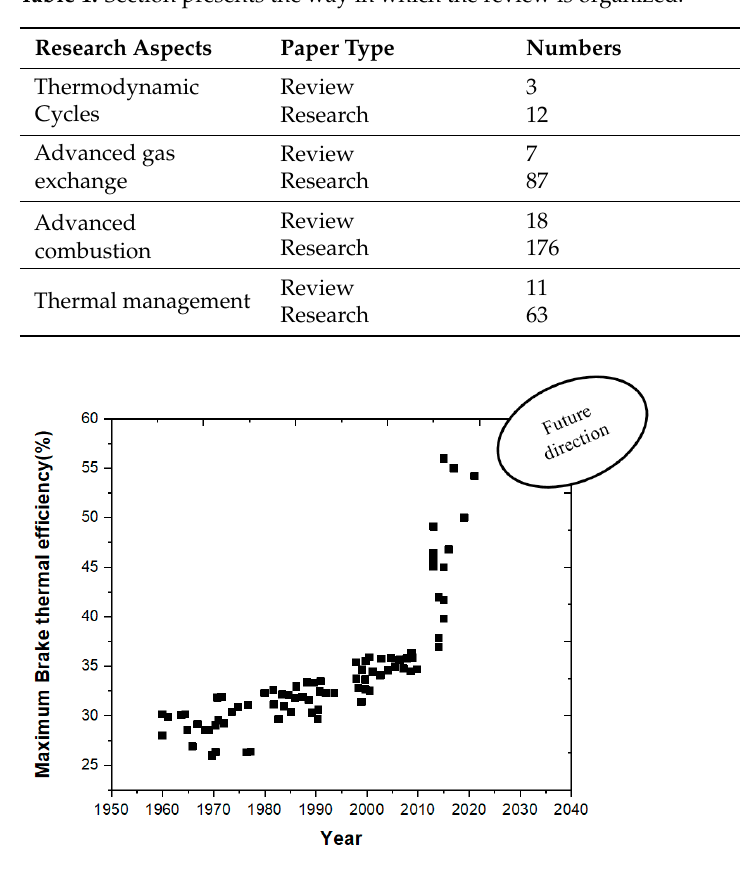
Figure 2. The history of the brake thermal efficiency and future direction [9,16–18,20] .